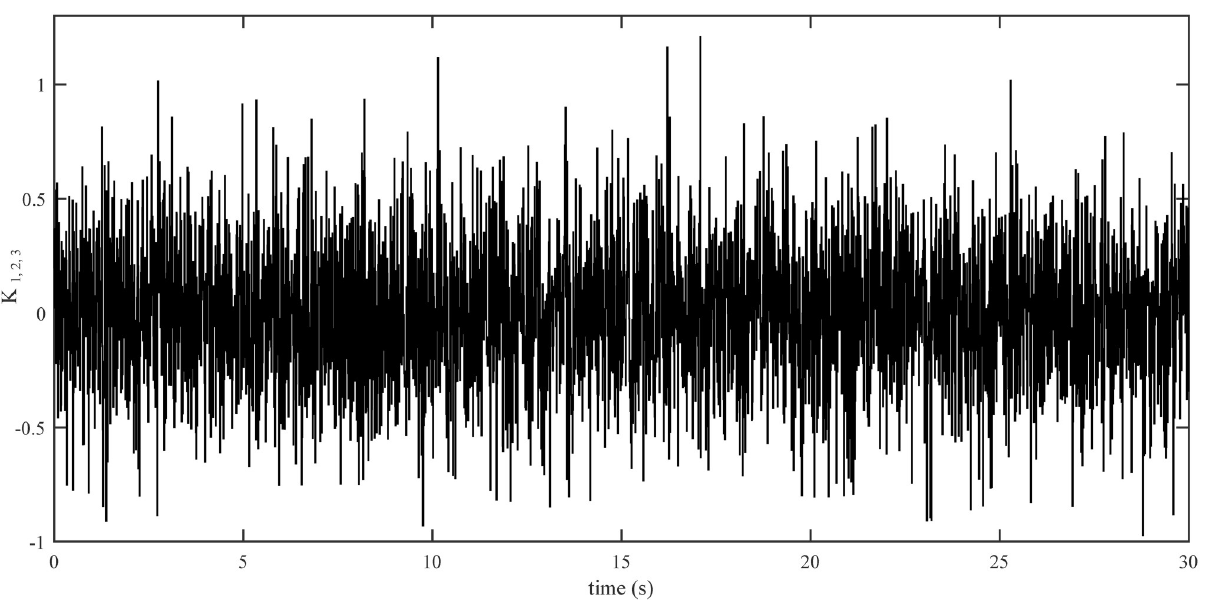
Fig 13. Drag coefficients for rotational